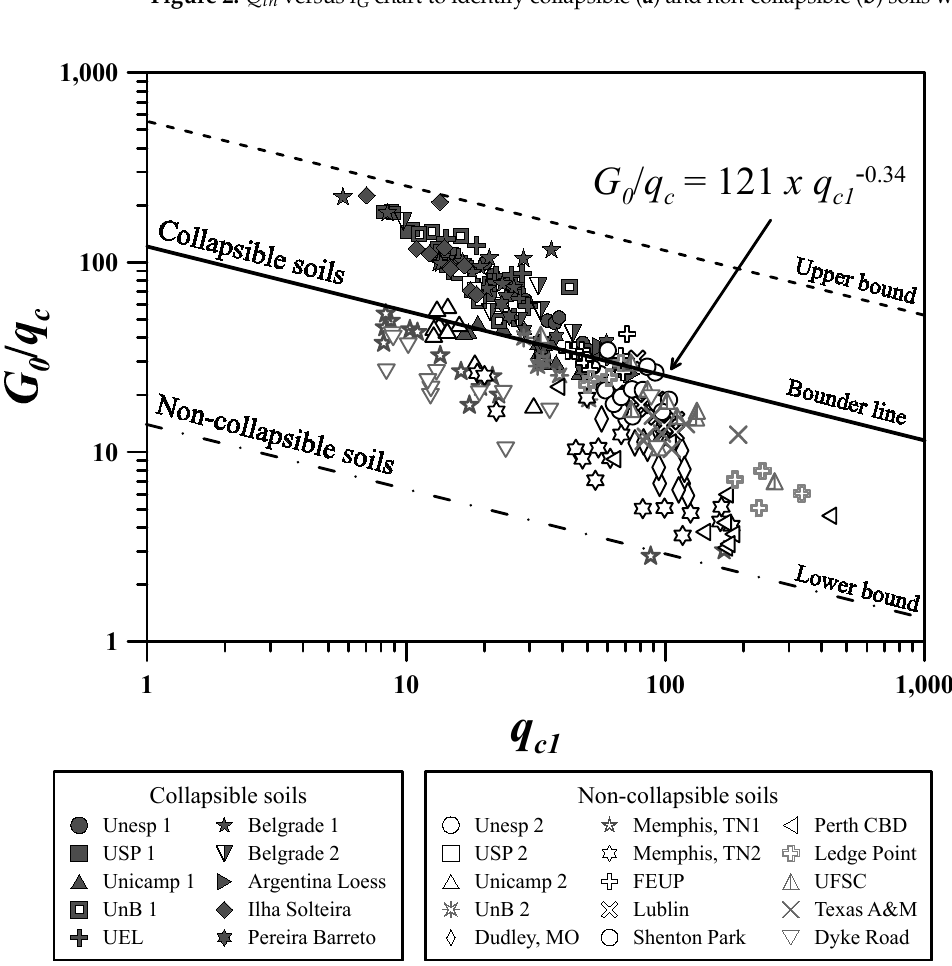
Figure 3. Upper and lower boundaries to separate collapsible from non-collapsible soils in the G 0 / q c versus q c 1 chart and the data for all sites.